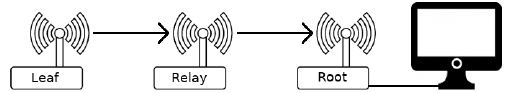
Figure 8. Topology used while comparing the consumption of a slot